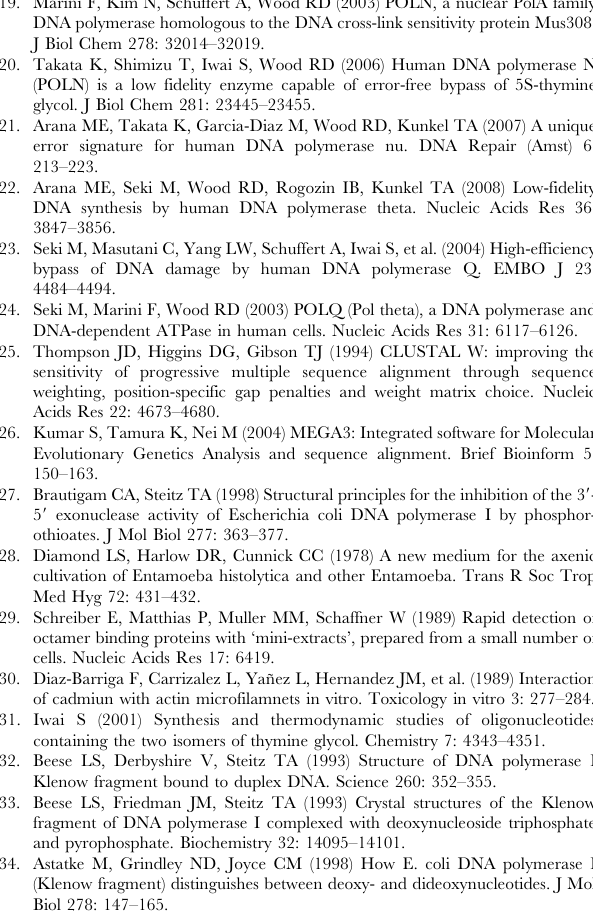
expressed 71% of the actin control. Standard deviations were calculated based on three independent experiments. Table S1 Putative DNA polymerases present in the genome of E. histolytica . This table presents a comparison between the putative DNA polymerases present in the genome of E. histolytica and homologous DNA polymerases. Table S2 GenBank accession numbers of the DNA polymerases used in the phylogenetic tree. This table contains the GenBank accession numbers of the DNA polymerases used to build the phylogenetic tree. Table S3 Kinetic parameters for nucleotide incorporation by EhDNApolA. This table contains the kinetics parameters (Km and Vmax) for nucleoide incorporation of